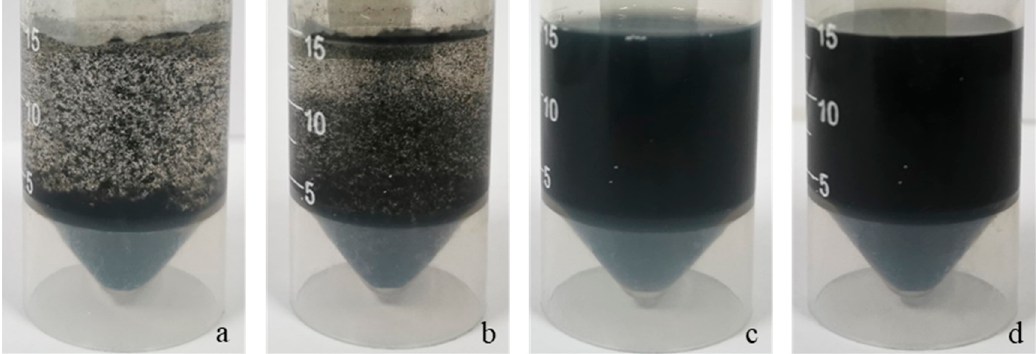
Figure 2. The images of Graphene/PVA suspension with different solid content ratios of ( a ) pure graphene, ( b ) 100:1, ( c ) 10:1, ( d ) 1:1 (w/w).